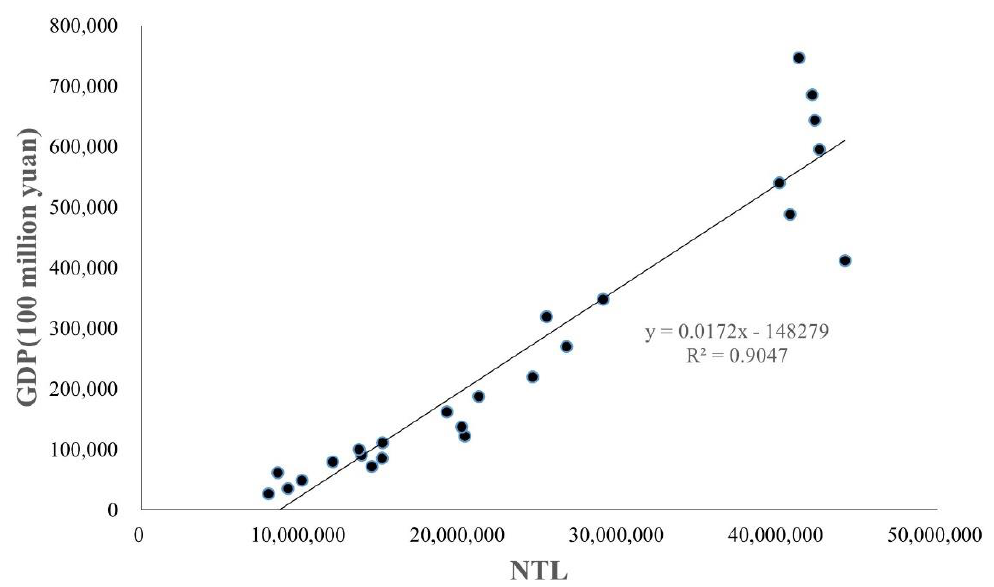
Figure 7. The NTL data and GDP in China from 1992 to 2016 (LR results).